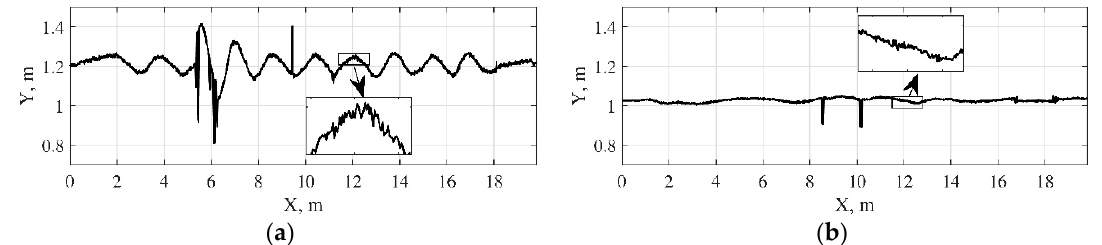
Figure 8. The route of the vehicle with the enlargement of the selected fragment ( a ) before filtration; ( b ) after filtration along.